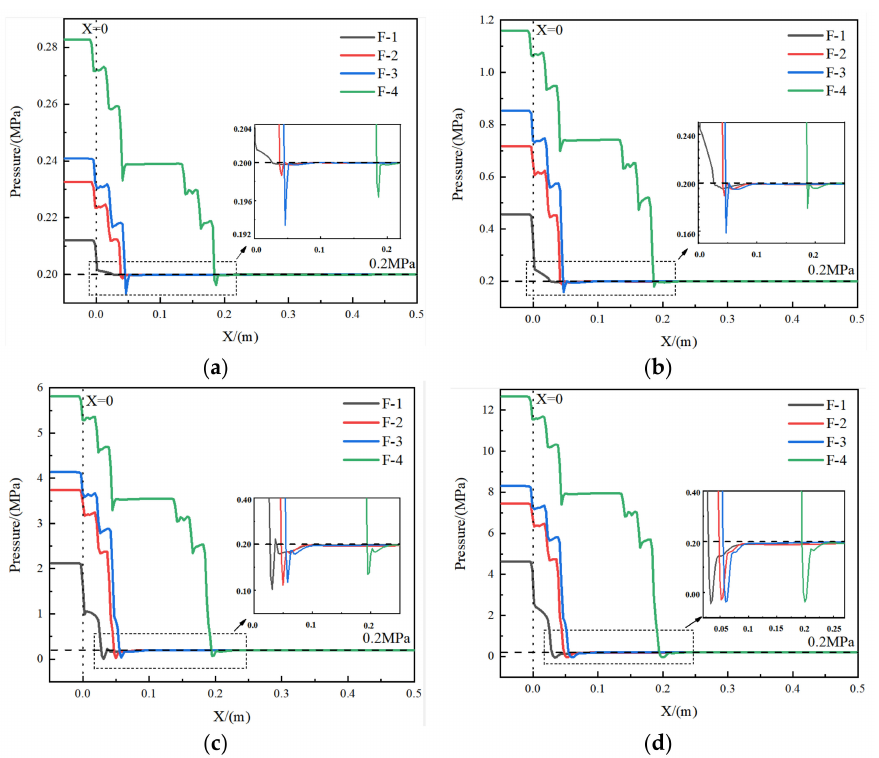
Figure 17. Pressure distribution on the centerline of the symmetry plane for the four structures under different mass flow rates. ( a ) Q m = 0.02 kg s − 1 . ( b ) Q m = 0.1 kg s − 1 . ( c ) Q m = 0.5 kg s − 1 . ( d ) Q m = 1 kg s − 1 .